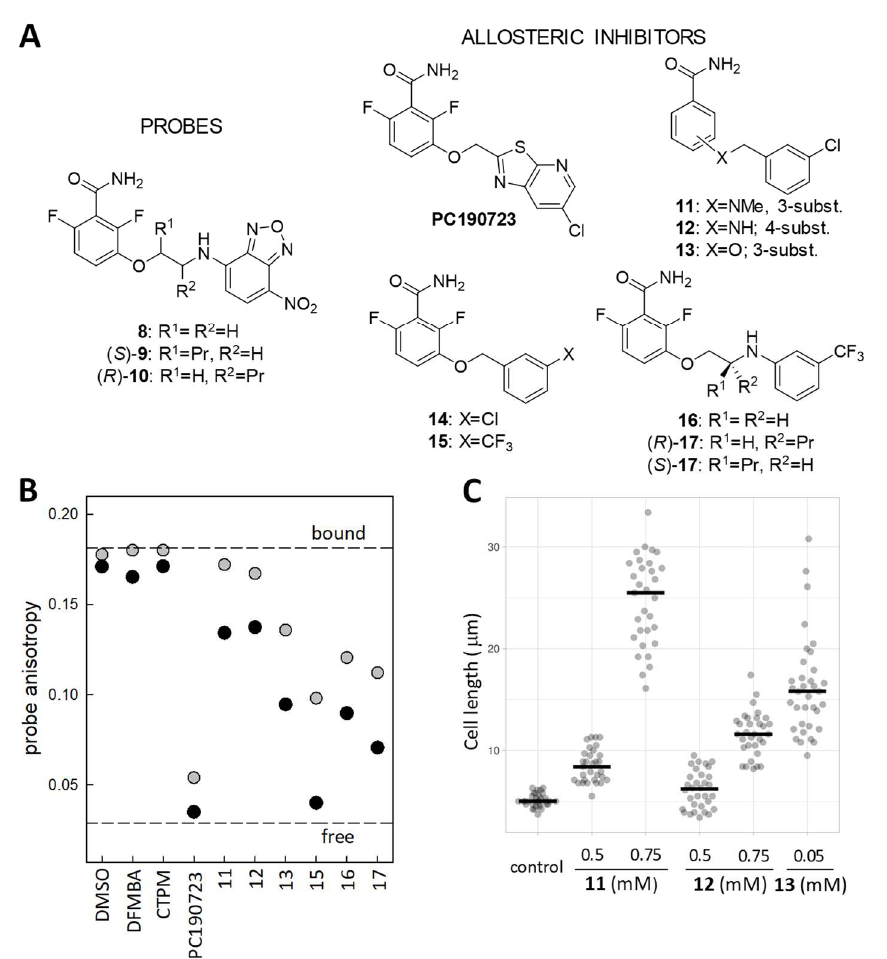
Figure 5. ( A ) Chemical structure of fluorescent probes and allosteric inhibitors targeting the FtsZ interdomain cleft. ( B ) Several examples from a florescence anisotropy screen for allosteric FtsZ inhibitors. The displacement of probe (S) - 9 (3 µ M) from stabilized BsFtsZ polymers (8 µ M binding sites) by two different concentrations of each compounds, 20 µ M (gray dots) and 200 µ M (black dots), is monitored. Control values with the solvent vehicle (DMSO), PC190723 and its 2,6-difluoro-3-methoxybenzamide (DFMBA) head and heterocyclic tail 6-(chloro [1,3] thiazolo [5,4- b ] pyridin-2-yl)methanol (CTPM), are included. The dashed lines represent the fluorescence anisotropy of the probe partially bound by FtsZ polymers and of the free probe. ( C ) Cell length measurements of B. subtilis cells treated with compound 11 , 12 , and 13 for 3 h. Raw data plots with mean values ( n ≥ 30)